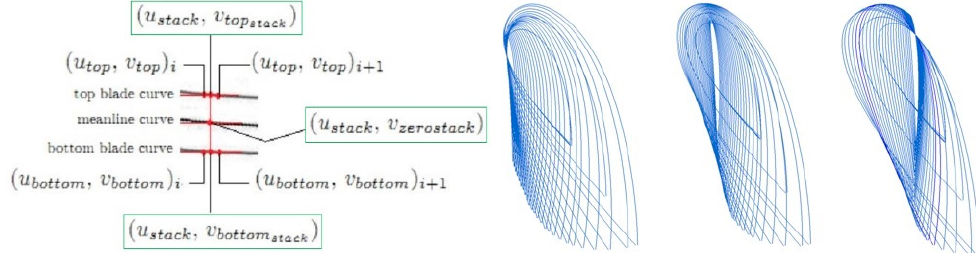
Figure 6. Coordinates on blade curves at a specified percent chord stack value with other stacking options. Wind turbine blade with 3D airfoils stacked on pressure side, meanline, and suction side from left to right.